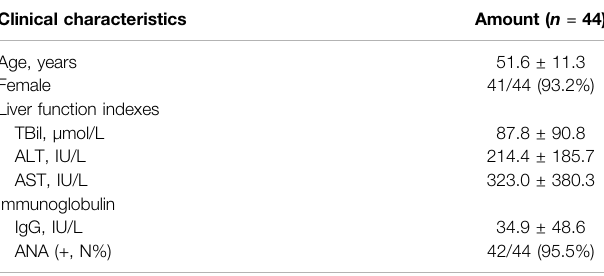
TABLE 1 | Clinical characteristics of patients with AIH in the study. Clinical